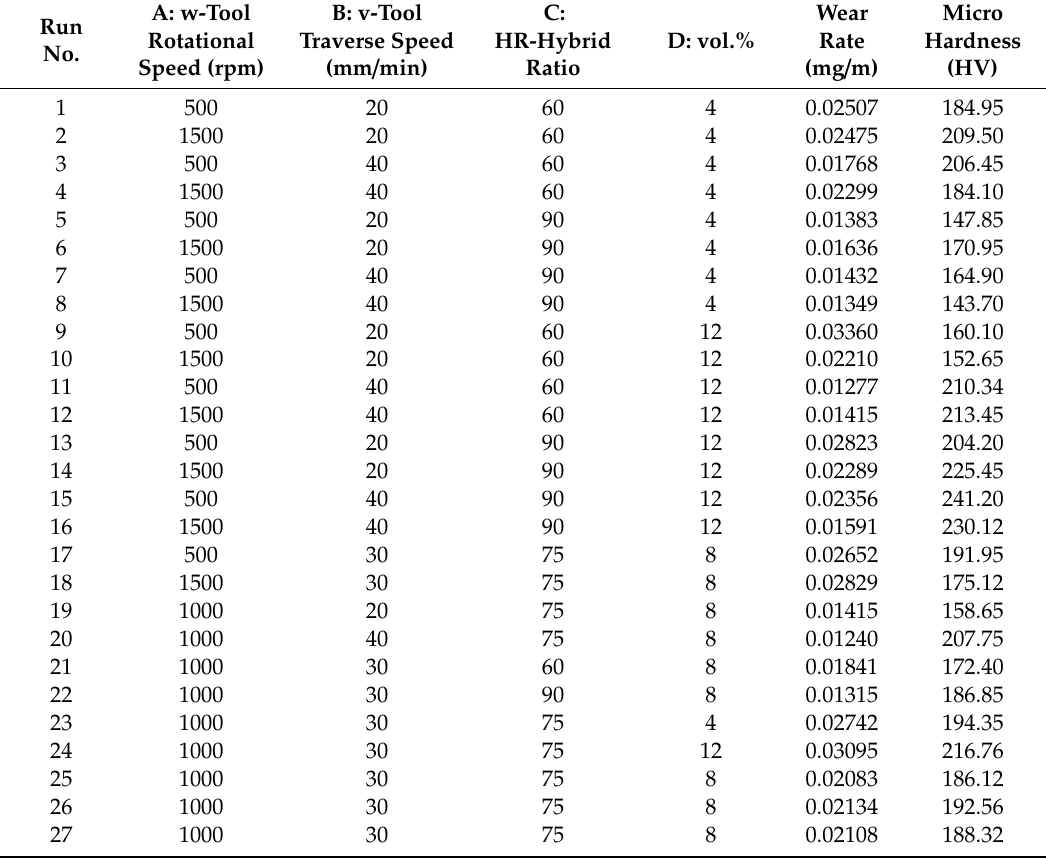
Table 2. Wear rate (mg / m) and microhardness (HV) of AA7075-SiC / fly ash